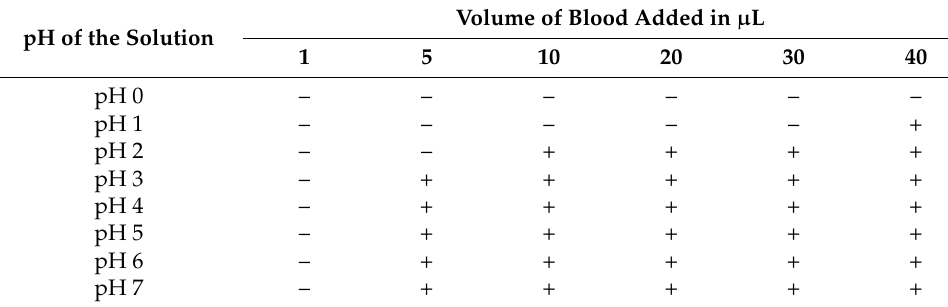
Table 2. Experiments to determine the effect of pH on colour